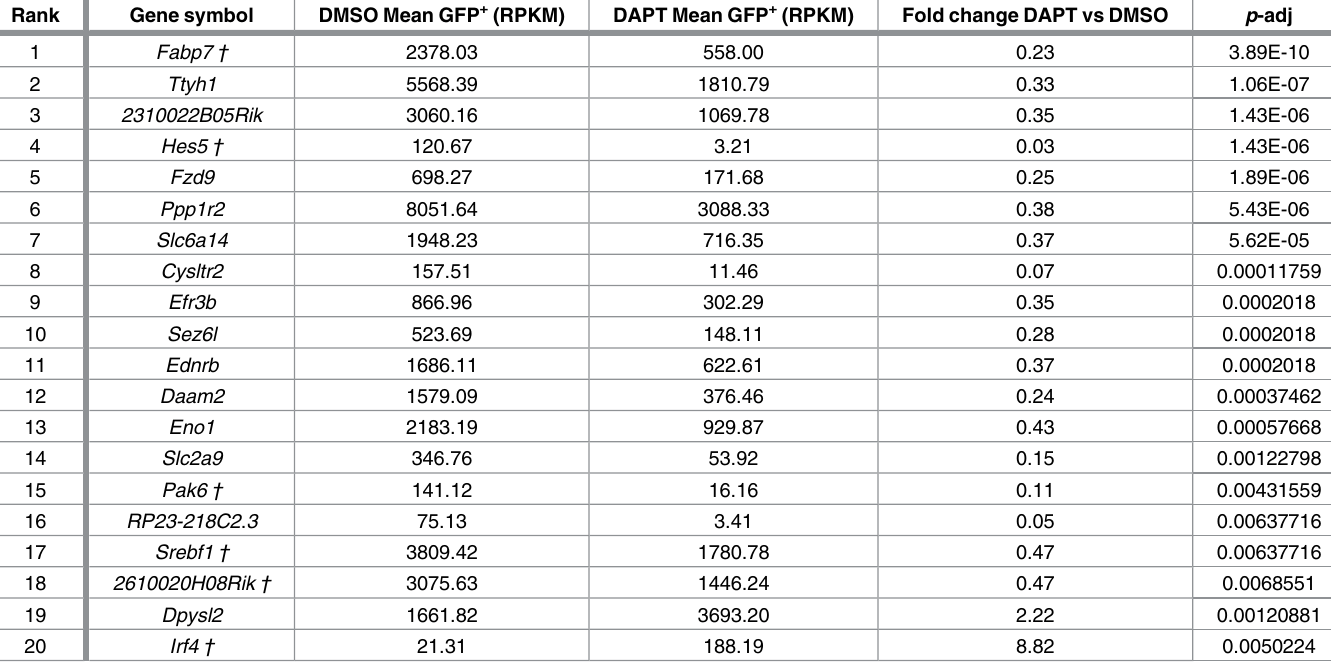
List of all genes showing the significant up- or down-regulation in P5 Lfng-GFP + cells after 24 hours DAPT treatment compared P5 Lfng-GFP + cells treated with DMSO vehicle. Ranking is based on the p value. The mean expression level (RPKM) is shown, together with the fold change versus DMSO-treated cells. p- adj = adjusted p -value for the difference between DAPT and DMSO-treated populations. † = genes also showing a significant change in DAPT-treated P0 cells (p <